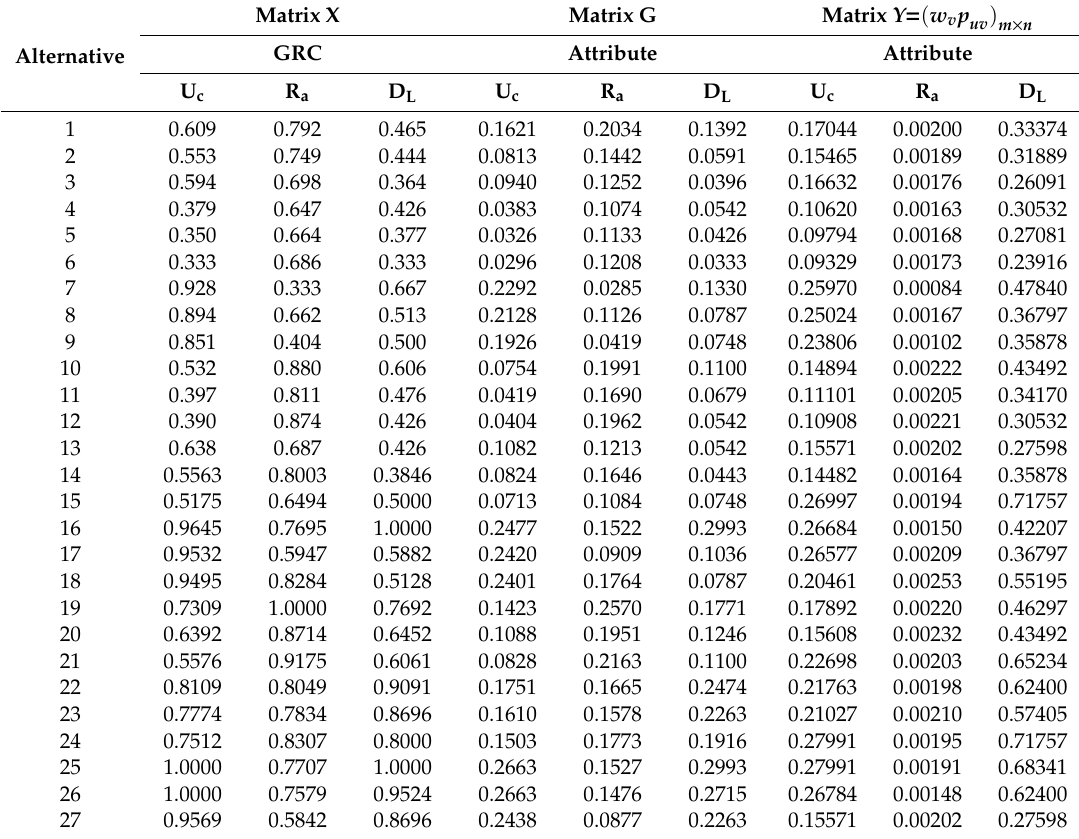
Table 6. Decision matrix [X], [G],